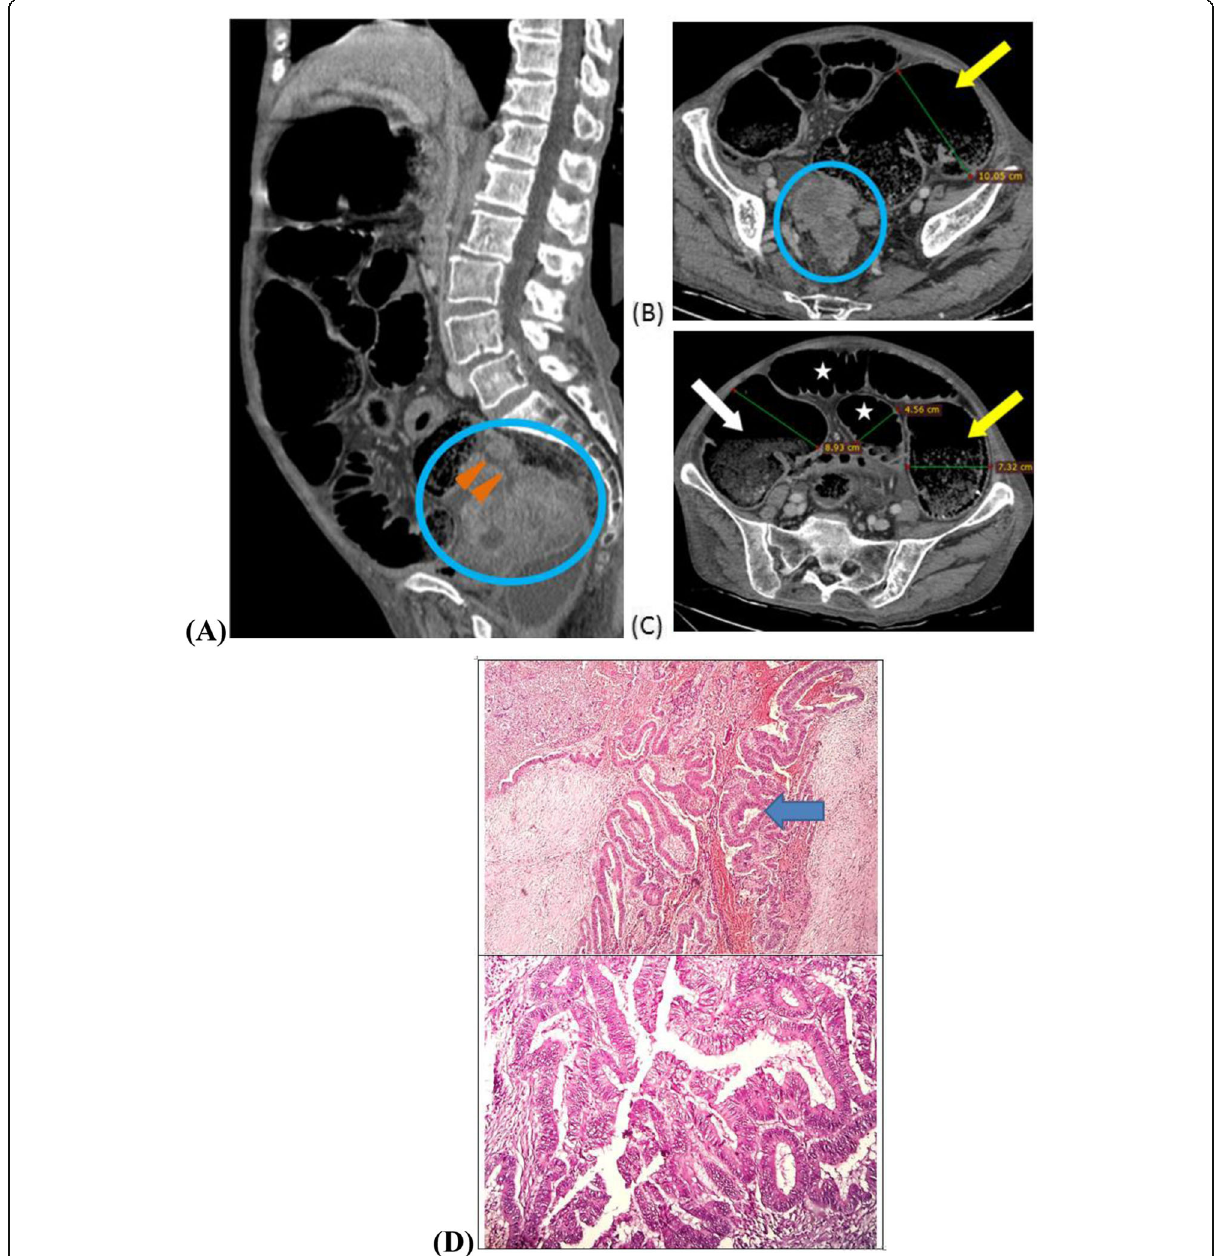
Fig. 5 Large bowel obstruction secondary to colorectal carcinoma with incompetent ilieo-cecal valve in an 80-year-old female presented with acute diffuse abdominal pain. a CT sagittal image showing heterogeneous enhancing mural thickening (circles), involving rectum and recto- sigmoid junction with luminal narrowing (arrow heads). b , c CT axial images showing dilatation of proximal large bowel loops (yellow arrows), cecum (white arrow), and small bowel loops (stars). d Histopathology showing irregular malignant glandular structures lined by several layers of pleomorphic cells infiltrating deep to the muscle layer, confirming the diagnosis colorectal moderately differentiated